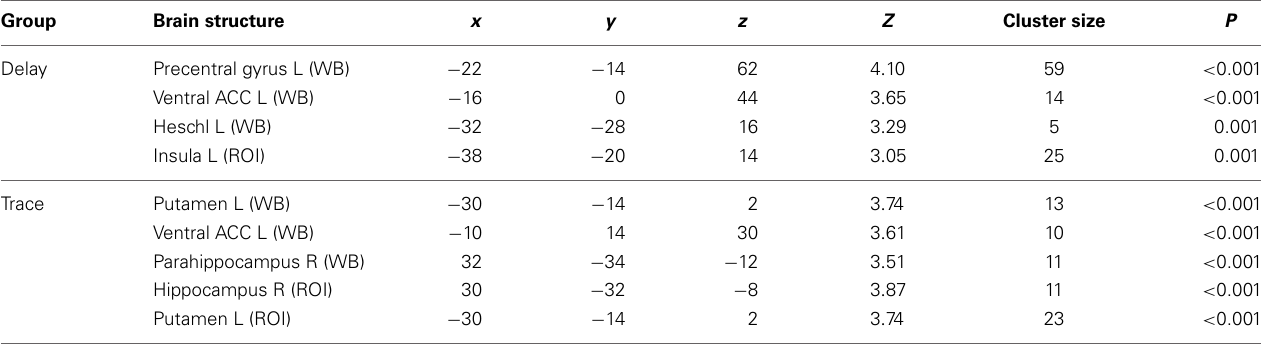
Table 3 | Early extinction (CS + > CS − ) > late extinction (CS + > CS − ): significant activations revealed by whole brain (WB) and regions of interest (ROI)